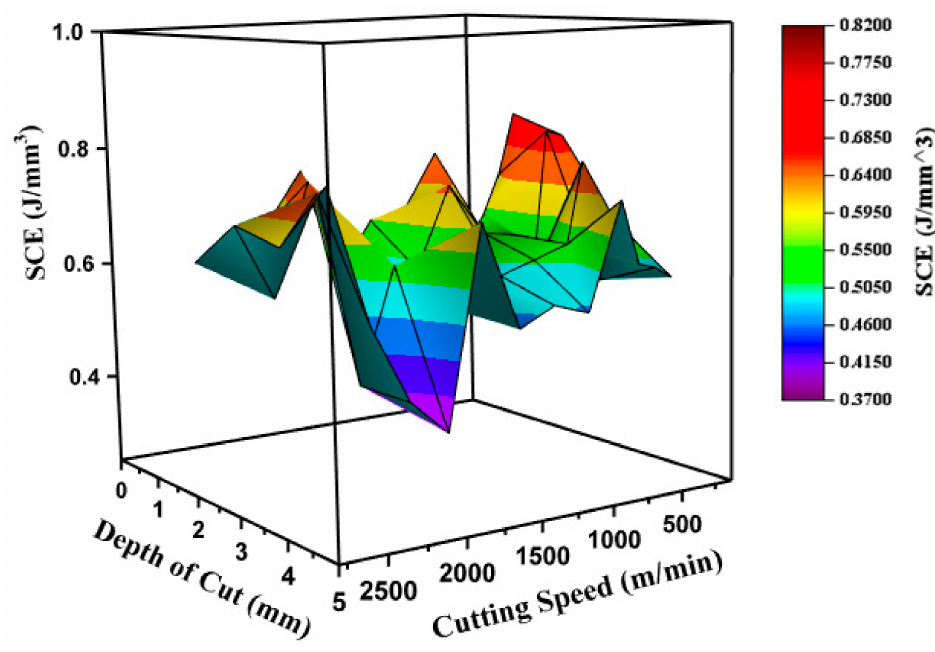
Figure 15. Effect of cutting speed-depth of cut on SCE in three machining